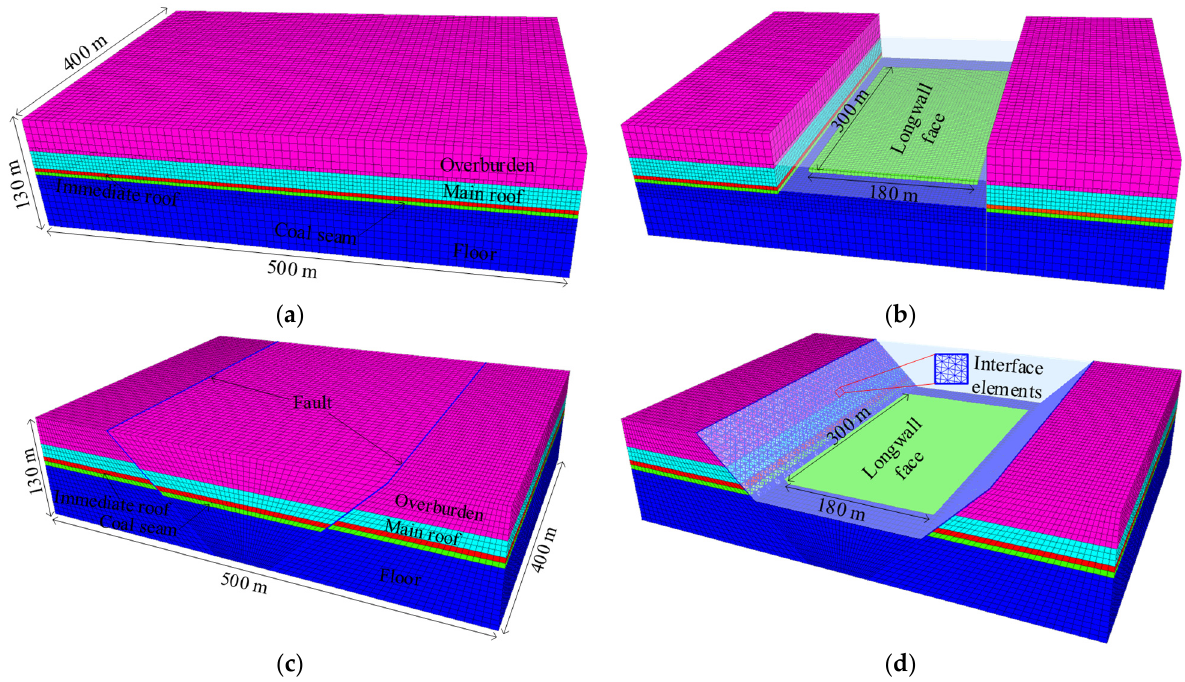
Figure 4. Numerical model of base model and graben fault model. ( a ) Grid model of base model. ( b ) Schematic of longwall face layout in base model. ( c ) Grid model of graben fault model. ( d ) Schematic of longwall face layout in graben fault model. The rock layers above the longwall face in ( b , d ) were made transparent in order to display the layout of the